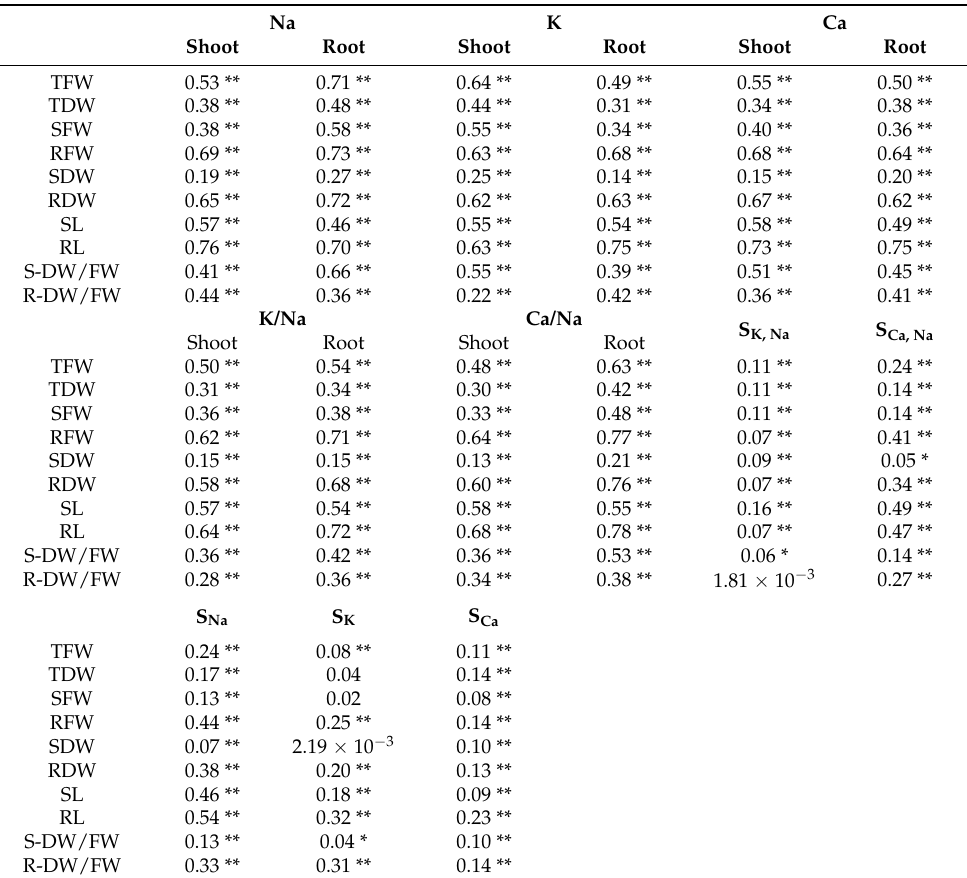
Table 3. Correlation coefficients between the growth indexes and the ion content parameters of all B. napus varieties under all treatments.